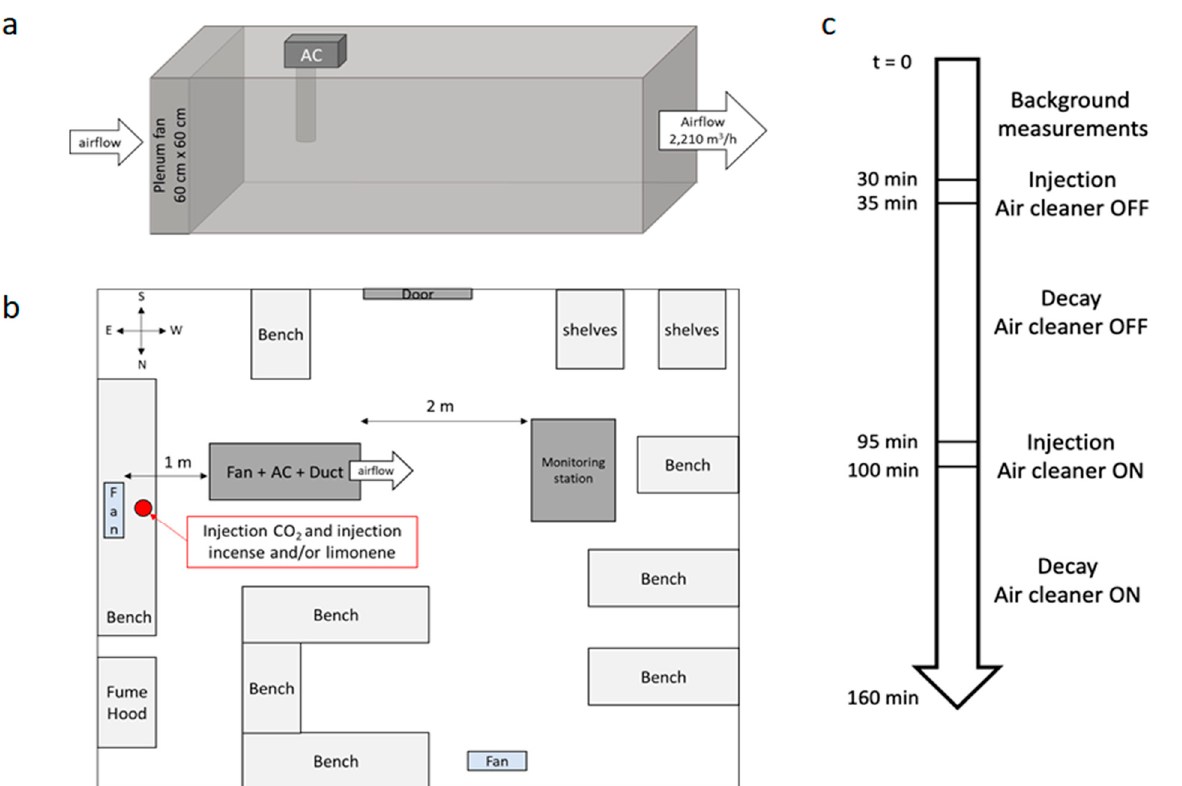
Figure 3. Controlled laboratory experiments in Portland, OR, USA, USA: ( a ) Schematic of a cardboard duct (170 cm × 61 cm × 61 cm) used as a makeshift air handler for these experiments where the air cleaner (AC) was placed 30 cm away from a plenum fan (60 × 60 cm). The fan air flow rate was set at 2210 m 3 /h. ( b ) Schematic of the laboratory where the experiments took place. Location of where injection of particles and limonene were performed is indicated with the red dot, 1 m away from the duct. Monitoring station was installed 2 m away from the duct. Two box fans were also installed in two locations in the laboratory to create a well-mixed environment. ( c ) Timeline of ex- periments.